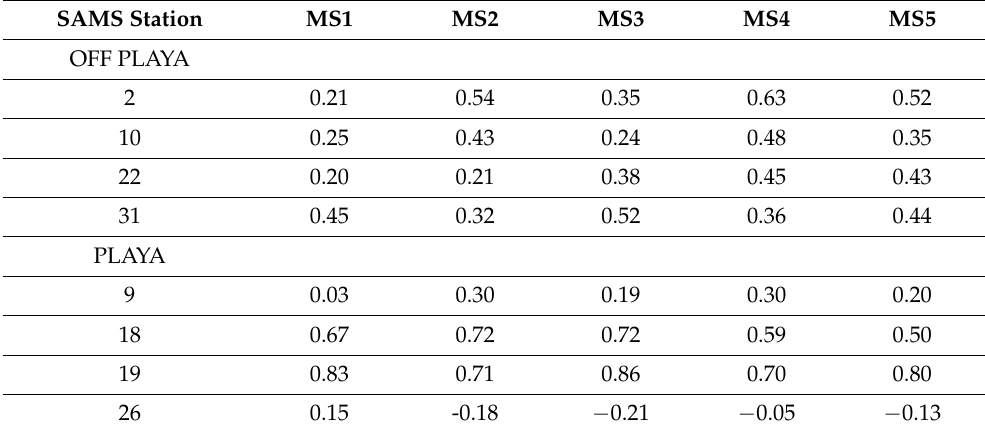
Table 10. Aggregate 10 m AGL v-wind component correlation-coefficient R values for each model